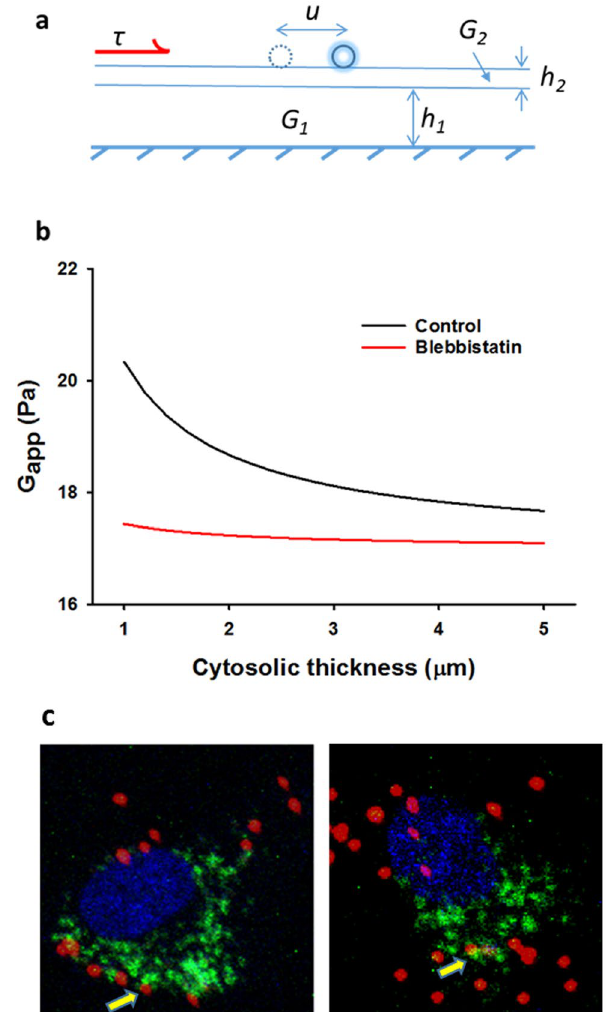
Figure 8. Theoretical interpretation of shear modulus and its experimental verification. ( a ) Modeling the cell as a two-layer elastic continuum exposed to shear stress at the top. The top layer represents the cell membrane and the actin cortex with modulus G 2 and thickness h 2 . The bottom layer models the cytosol with modulus G 1 and thickness h 1 . When the top surface is exposed to shear stress ( τ ), the bead moves to the right by a displacement u . ( b ) Simulation of apparent shear modulus ( G app ) of the model as a function of the thickness of the cytosolic layer in control cells (black line) using Eq. 3. The red line shows the simulated effect of blebbistatin by reducing G 2 (see text for details). ( c ) Example images of a single cell labeled for nucleus (blue), beads (red) and lysosomes (green). The G was computed from the beads above lysosomes as well as from lysosomes where possible (yellow